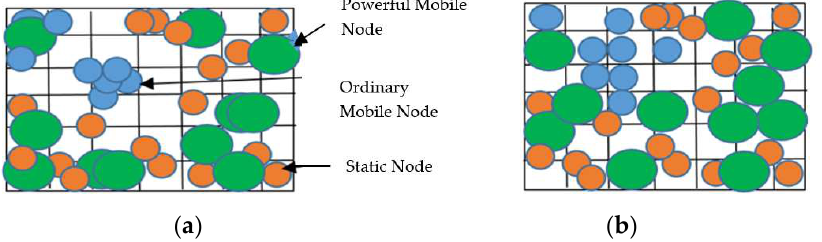
Figure 5. ( a ) Before network coverage optimization ( b ) After network coverage optimization. Algorithm 2 : Energy-efficient node deployment